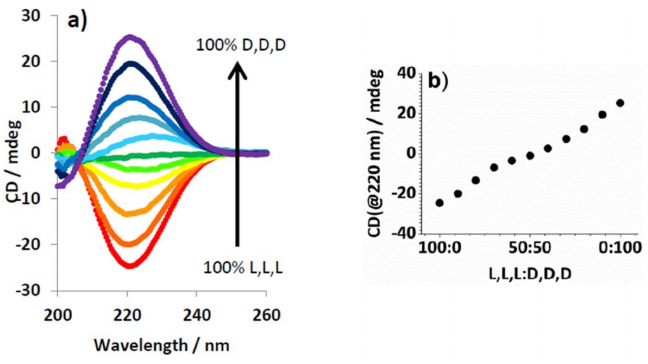
Figure 3. ( a ) CD spectra of mixtures of L,L,L and D,D,D (total concentration = 0.625 mM in), changing in 10% concentration increments in the presence of C8 (0.625 mM) from 100% LLL (red) to 100% LLL (purple); ( b ) Data extracted from graph ( a ) at 220